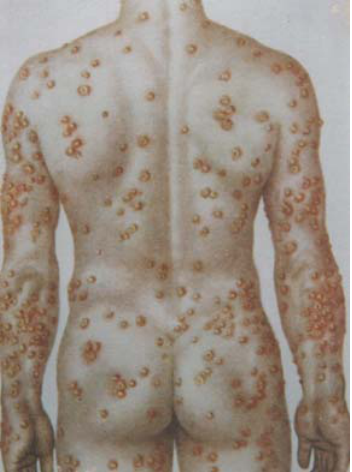
FIGURE 1 . Mosaic focal distributions of specific lesions in a case of human